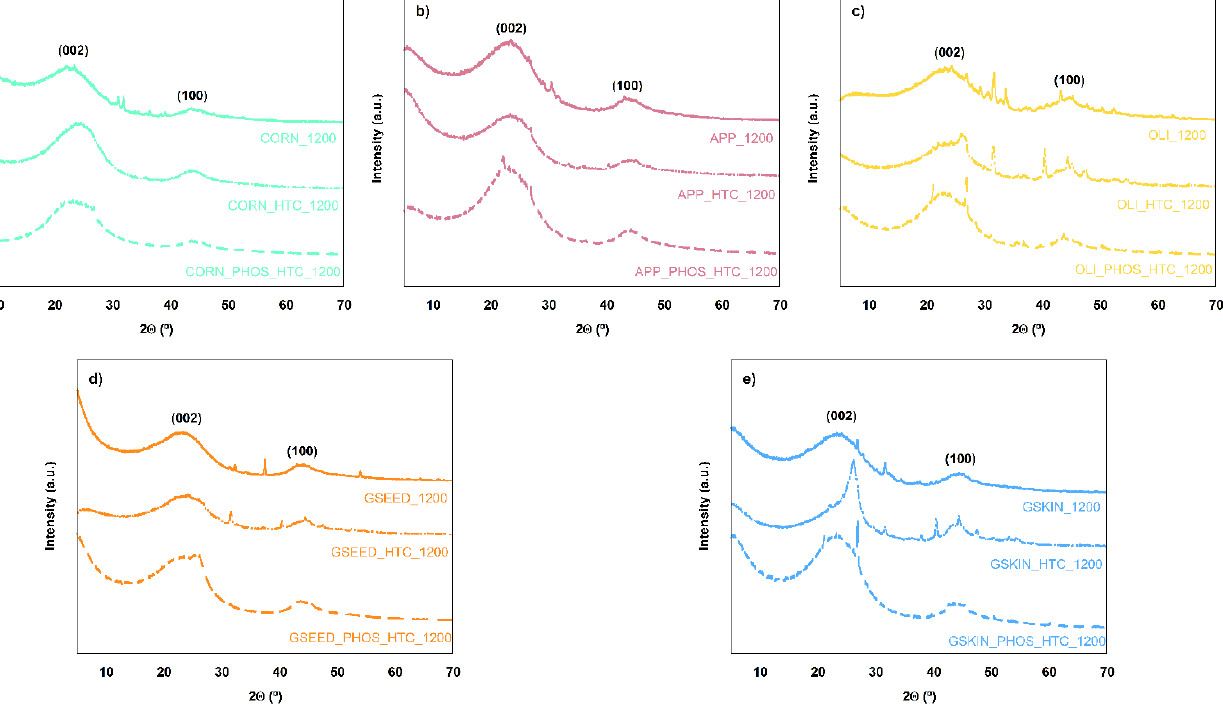
Figure 2. X-ray diffraction diagrams of corn cob ( a ), apple pomace ( b ), olive mil solid waste ( c ), defatted grape seed ( d ) and dried grape skin ( e ) samples.